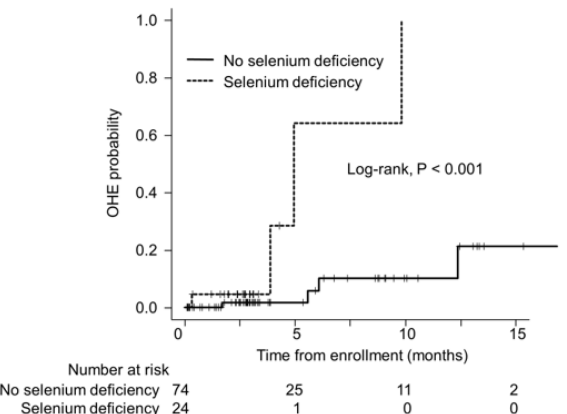
Figure 2. Cumulative incidence of OHE in patients with and without selenium deficiency. OHE probability was estimated using the Kaplan–Meier method and compared between the two groups using the log-rank test. OHE, overt hepatic encephalopathy.